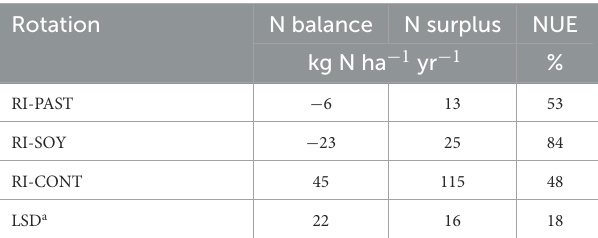
TABLE 3 Calculated N balance, N surplus and % N use efficiency (defined in Equations 4–6) for the three rotations from 2012 to